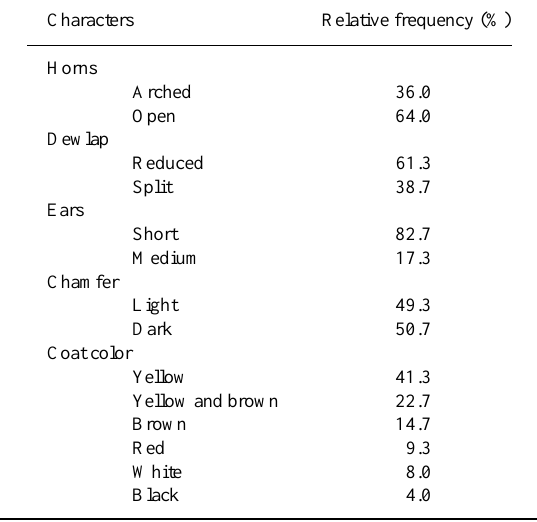
Table III - Phenotypic characteristics of 75 “pé-duro” bulls of Embrapa (Piauí). Characters Relative frequency